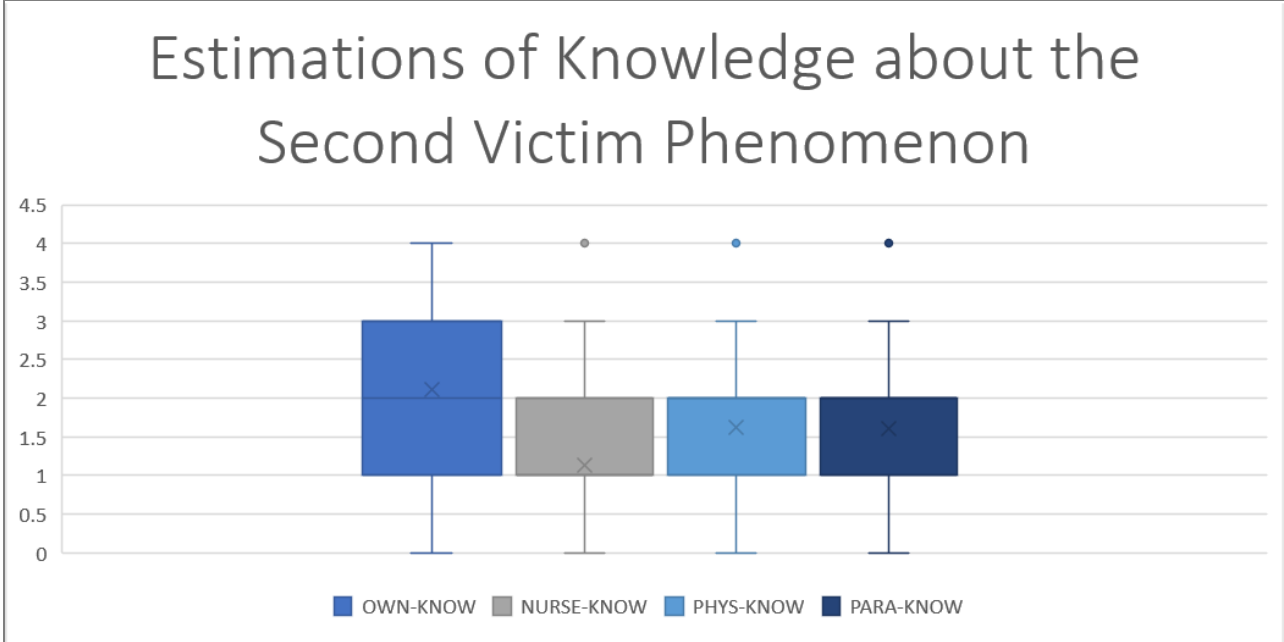
Figure 2. Estimations of one’s own and others’ knowledge (KNOW) about SVP for own, nurses (NURSE), physicians (PHYS) and paramedics (PARA). The Y ‐ axis displays points according to the Likert scale with a minimum of 0 and a maximum of 4, showing the over ‐ placement of participants above all other professional groups.